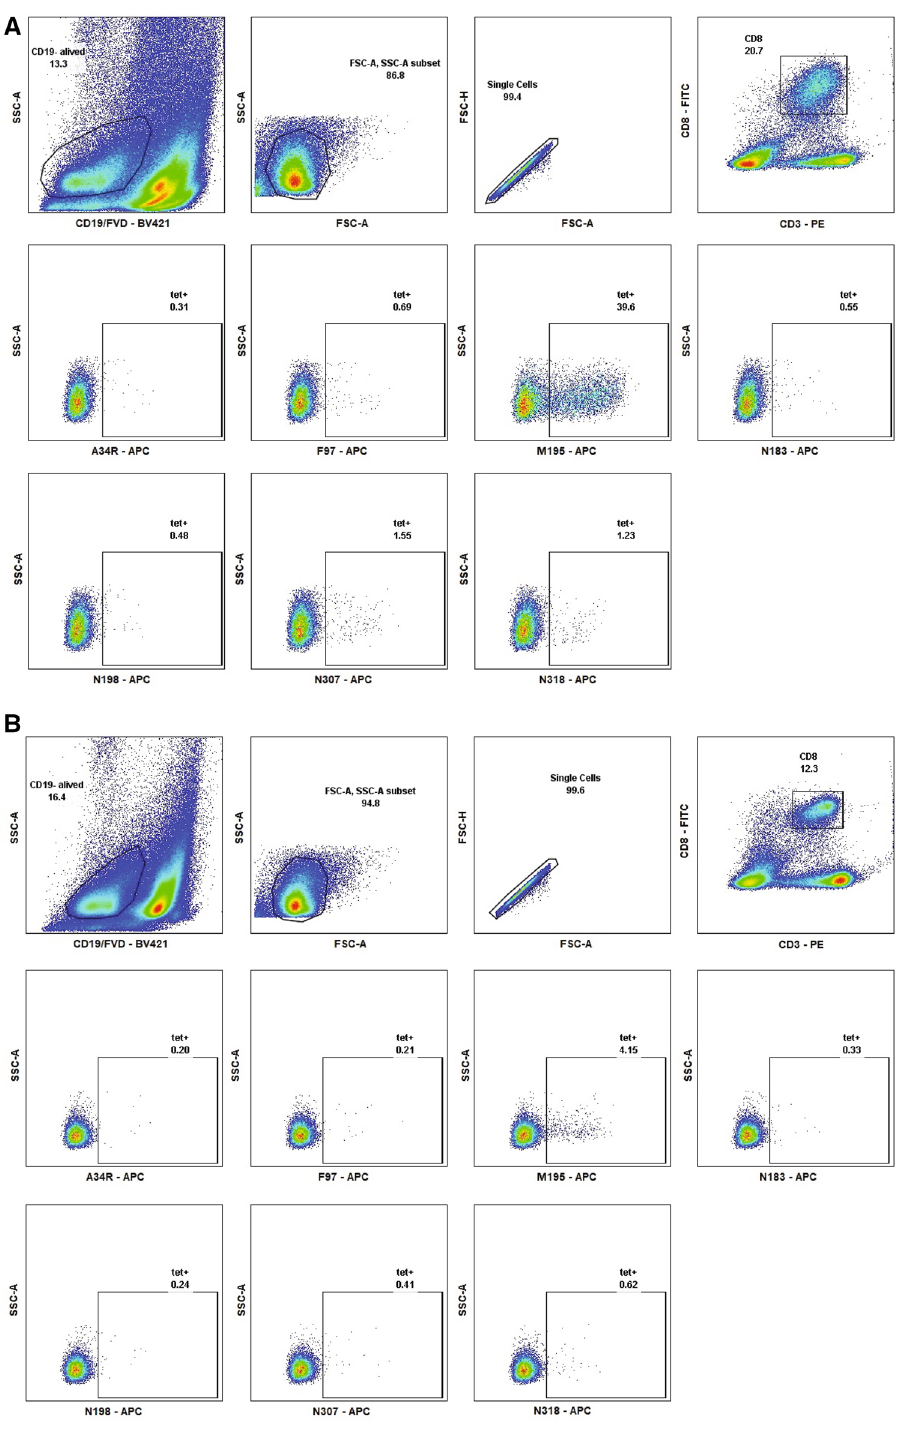
Figure 2. HMPV-specific T CD8 identified with fluorescently labeled HLA tetramer molecules in B7tg mice. B7tg mice were infected i.n. with 1 × 10 6 PFU HMPV and lungs ( A ) and spleens ( B ) collected on day 10 post- infection. Live/dead dye and fluorescently labeled CD8 and CD3 antibodies were used to identify live CD8 + T lymphocytes and fluorescently labeled HMPV-specific tetramers, as well as an irrelevant vaccinia virus (A34R) tetramer, were used to identify HMPV epitope-specific T CD8